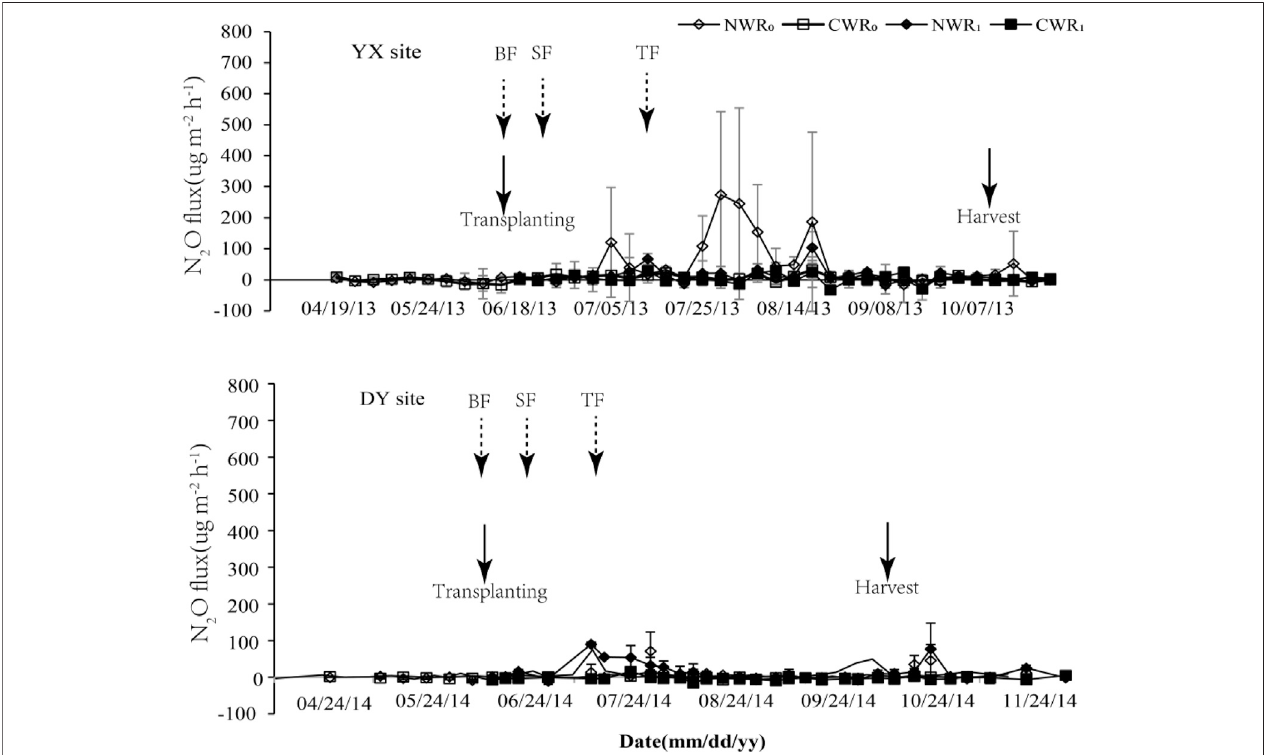
FIGURE 2 | Annual N 2 O emissions from the CW and the NW paddy fi elds under different treatments. Note: CWR 0 and CWR 1 are cold-waterlogged paddy fi eld withoutand withriceplanting, respectively; NWR0 and NWR1 arenormal paddy fi eldwithout and withriceplanting, respectively. Thevalues aremeans ± SD ( n (cid:2) 3). BF, SF, and TF are base fertilization, seedling fertilization, and tillering fertilization.